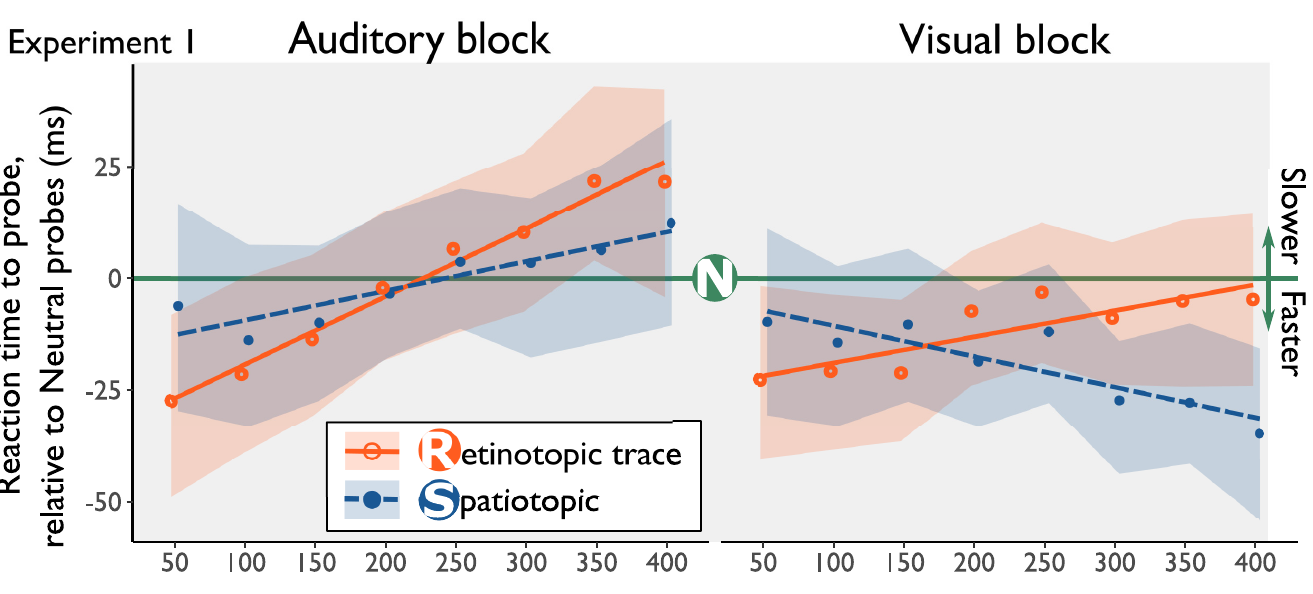
PLOS ONE | https://doi.org/10.1371/journal.pone.0202414 August 20,